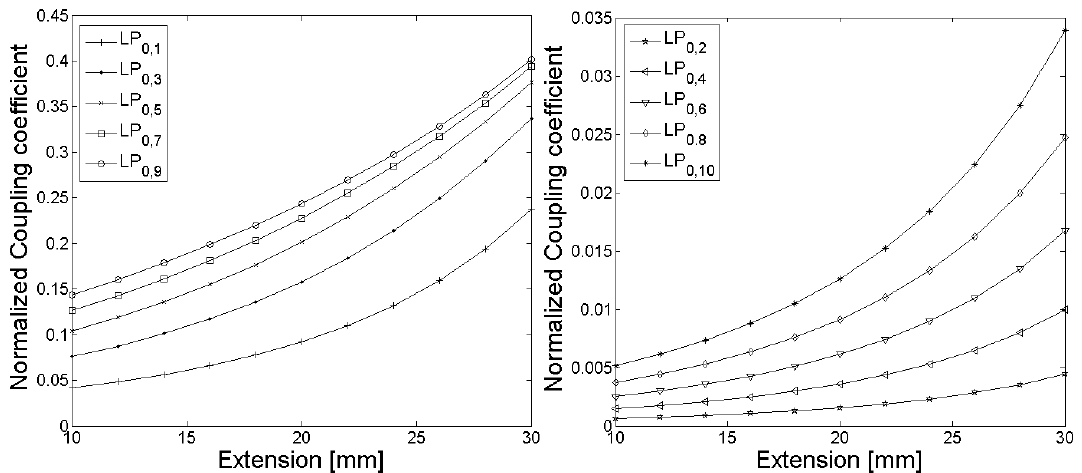
Figure 7. The normalized coupling coefficients as a function of the fiber extension during the tapering process for coupling of light from the fundamental LP 0,1 core mode to the LP 0,1 –LP 0,10 cladding modes for the SM1500 fiber with a starting cladding diameter of 80 μ m are shown, whereby modes with odd mode numbers ( left ) have significant larger normalized coupling coefficients compared to the modes with even mode numbers ( right ).